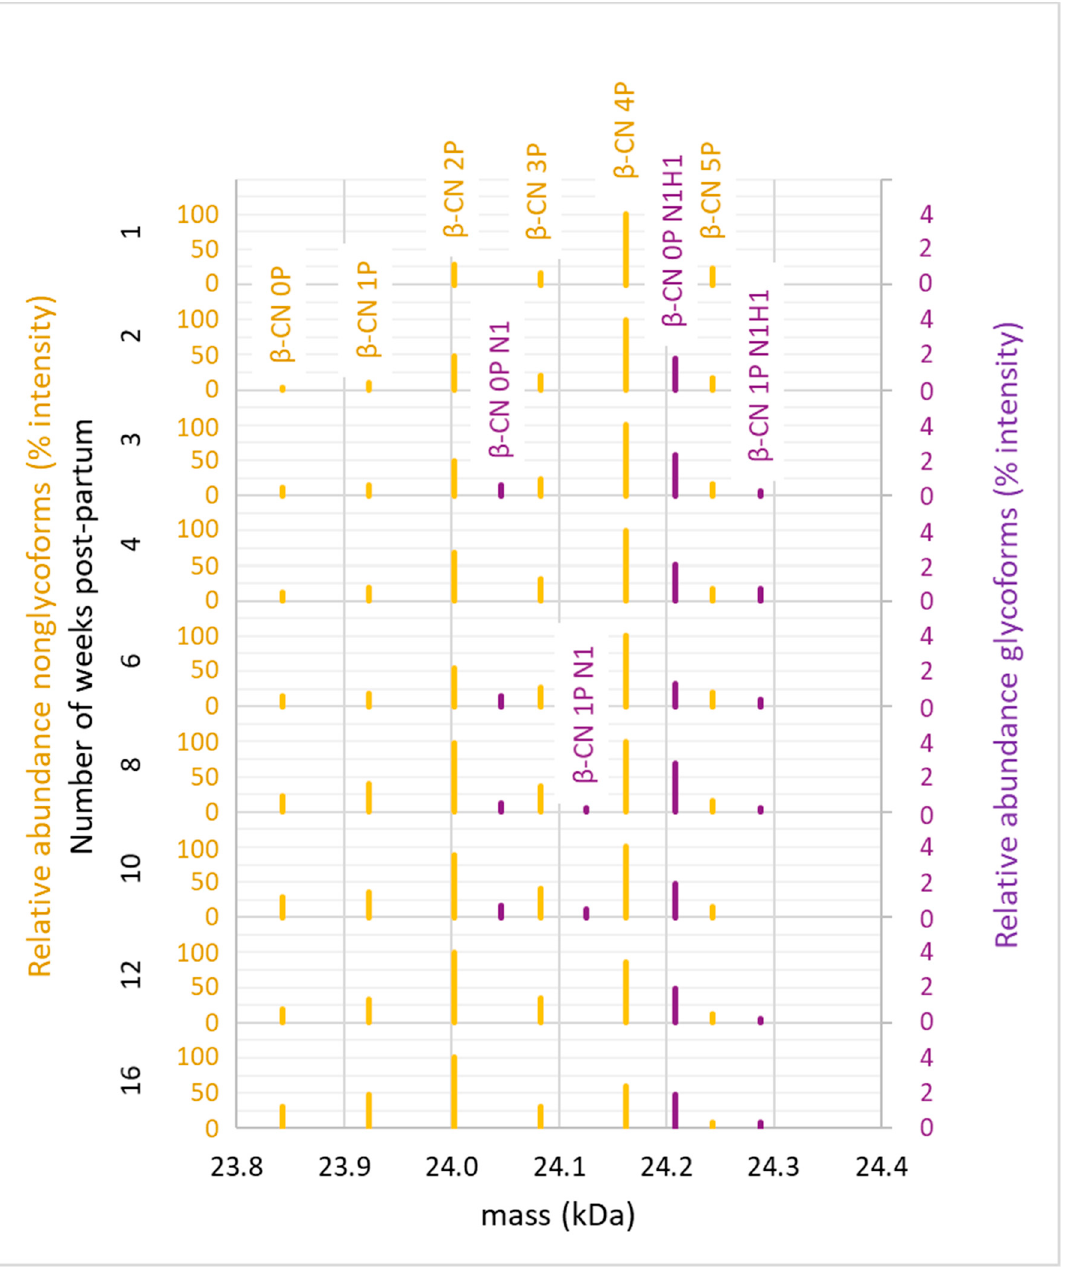
Figure 2. Deconvoluted mass spectra depicting the β -casein proteoforms identified in the whole milk of donor two throughout lactation. The non-glycosylated proteoforms (yellow) comprised phosphorylation in the range of 0–5P and were confirmed by database search of the intact protein LC-MS/MS results. Minor glycosylated proteoforms (~0–4% relative abundance of the most abundant β -casein proteoform; purple) could be annotated in the intact protein LC-MS data by the mass shift induced by the glycan residue masses.